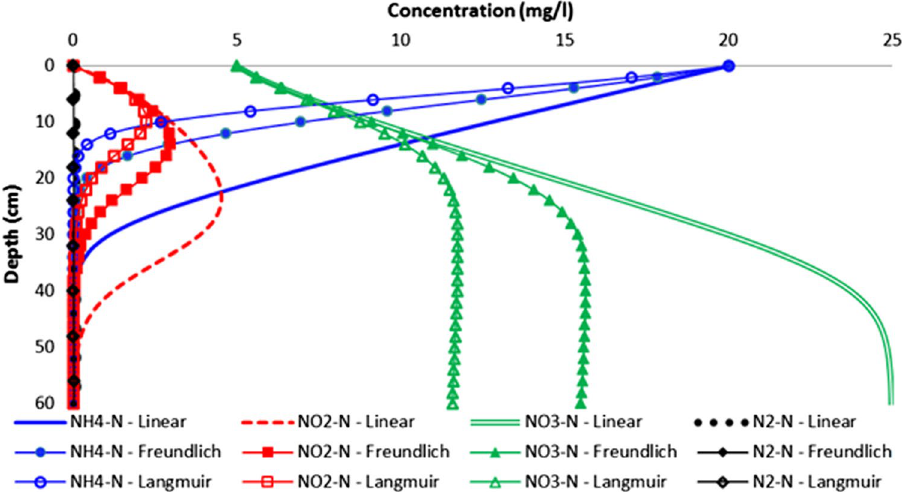
Fig. 6 Concentration profile for different nitrogen species with linear, Freundlich and Langmuir isotherms at the end of 50 days of wastewater application (refer to Tables 2 and 3 for other